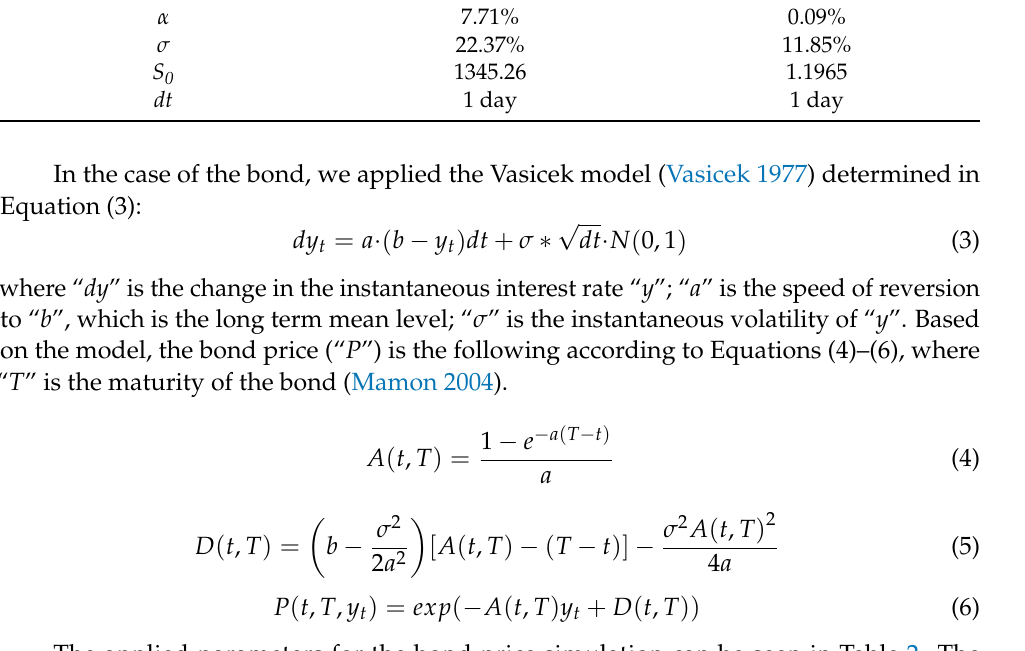
Table 1. The parameters of the price simulation in the case of the stock and the currency. Parameter Stock